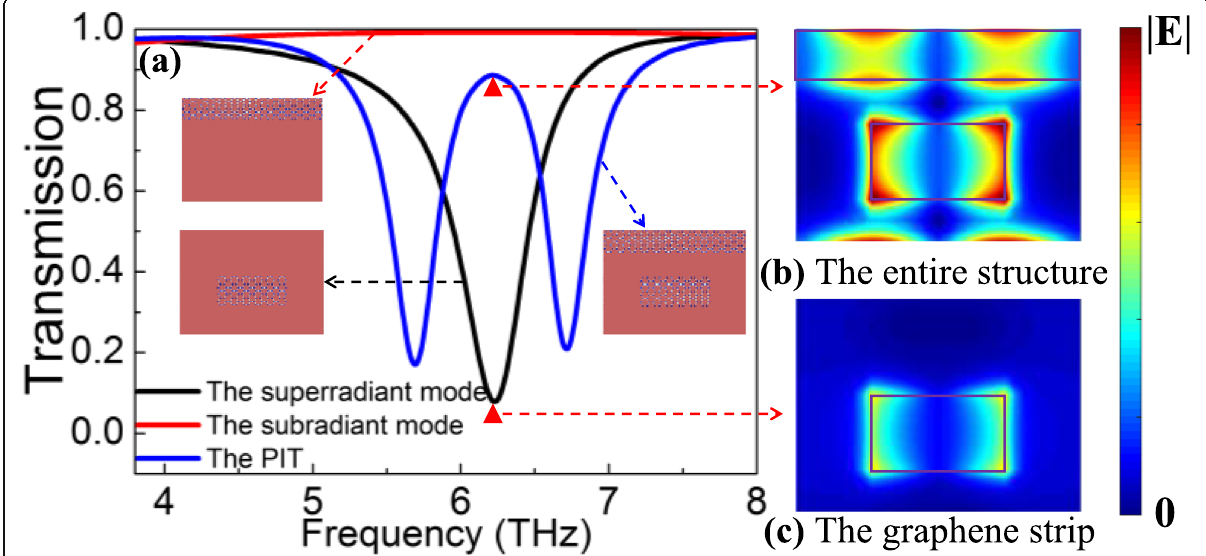
Fig. 2 a Simulated transmission spectra of three graphene metasurfaces. b Electric field distribution of the entire structure at the resonance peak. c Electric field distribution of the graphene strip at the resonance dip. Here, E f 1 = E f 2 = 1.0